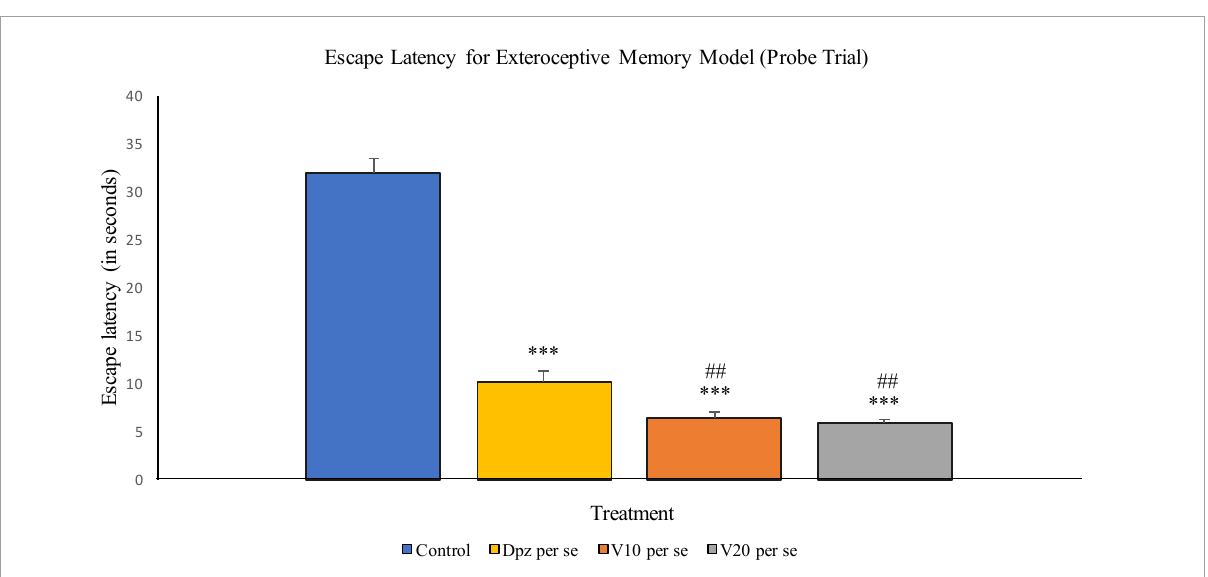
FIGURE6 Effect of vanillin and other treatments on escape latency (probe trial). Data are expressed as mean ± SEM. “***” denotes P < 0.001 with respect to the control group within the probe trial. “###” denotes P < 0.001 with respect to the standard treatment group within the probe trial.